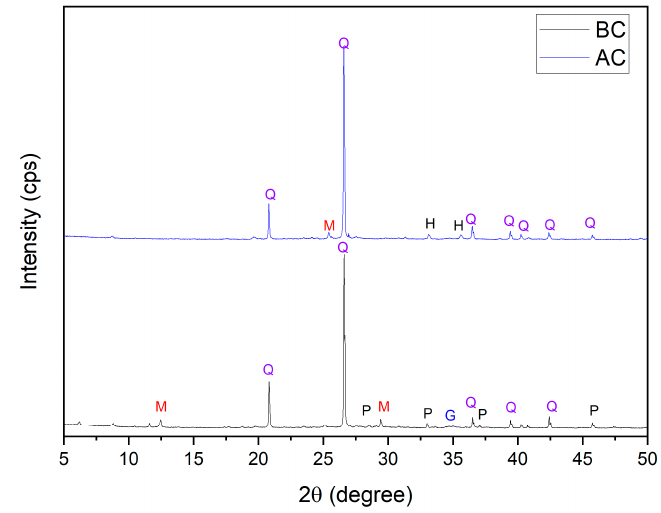
Figure 1. XRD pa tt erns of mining tailings. BC: before calcination and AC: after calcination. (Q: Figure 1. XRD patterns of mining tailings. BC: before calcination and AC: after calcination. (Q: quartz, M: muscovite, H: hematite, P: pyrite, G: geocronite). Table 2. Experimental conditions and products obtained from synthesis